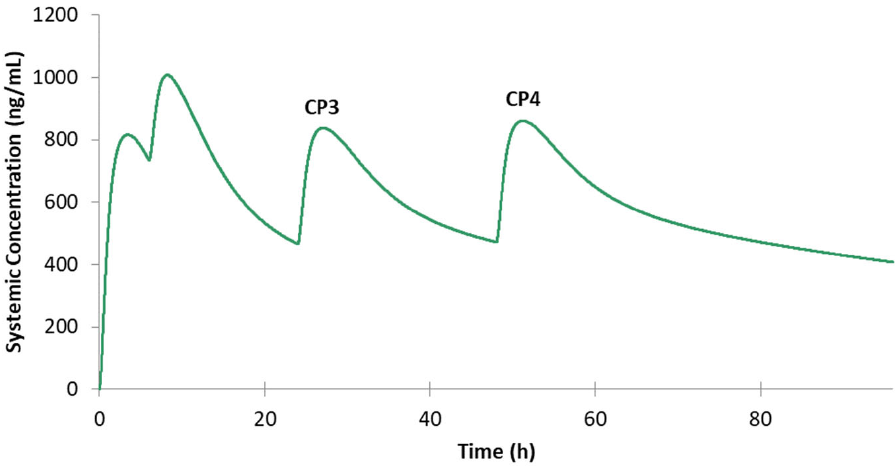
Figure 2. Validation of HCQ model under multiple dosing. The green curve represents the mean value of the simulated virtual subjects, and the grey curves represent the 90% confidence interval. The yellow dots represent the clinical reported PK data of 400 mg HCQ every week.